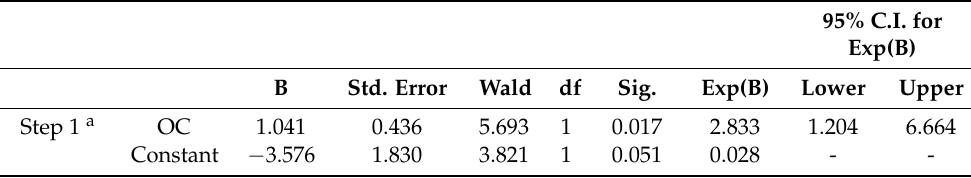
Table 18. Organisation competency: regression analysis for